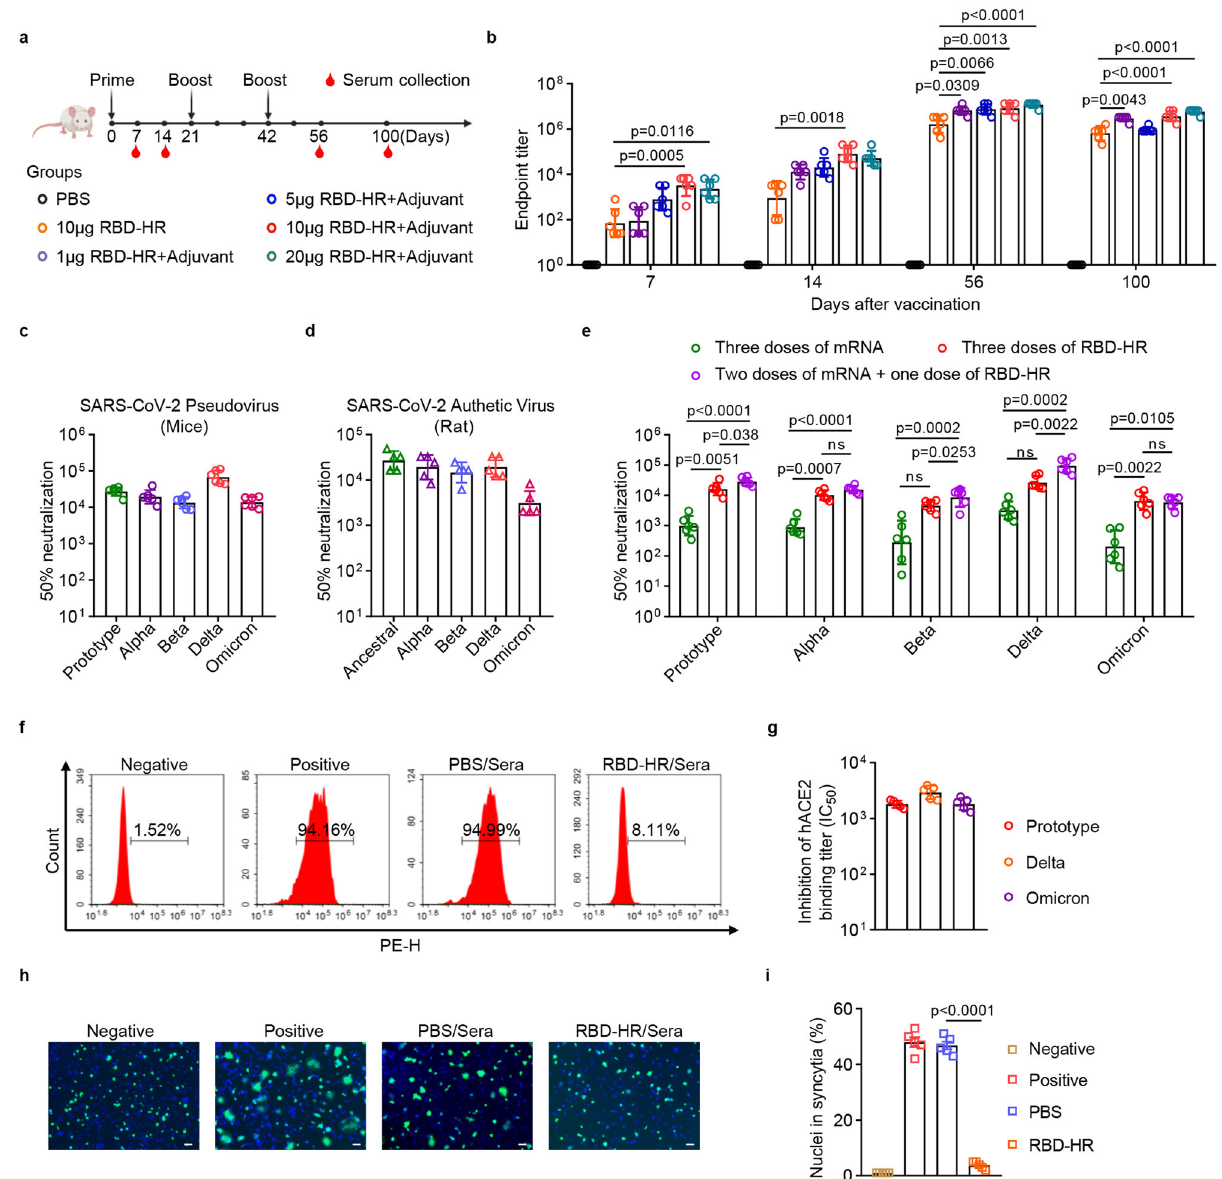
Fig.2|Inductionofsustainedhumoralimmuneresponsewithbroad-spectrum neutralizing activities by RBD-HR/trimer vaccine. a The schematic representa- tion of the mouse immunization and sample collection protocol. b The assay of endpoint titers of anti-RBD IgG induced by RBD-HR/timer vaccine was performed by ELISA ( n =6 mice per group). c Neutralizing antibody titers against pseudo- virusesinserafrom n =6micevaccinatedwith10 μ gadjuvant-formulatedRBD-HR/ trimer vaccine were determined by pseudovirus neutralization assay. d Neutralizingantibodytitersinserafrom n =5ratsimmunizedwith60 μ gofRBD- HR/trimer vaccine against authentic SARS-CoV-2 virus were determined. e Neutralization antibody titers of sera from mice immunized with three doses of mRNA,threedosesofRBD-HR/trimer,ortwodosesofmRNAfollowedonedoseof RBD-HR/trimer ( n =6 mice per group). f Representative graphs of fl ow cytometry represent blockade ofRBD-Omicron binding to cell-surface humanACE2receptor by the immunized sera. Negative control: cells stained with PE-conjugated anti- humanIgGFcantibodiesonly;Positivecontrol:intheabsenceofsera;PBS/Sera:in